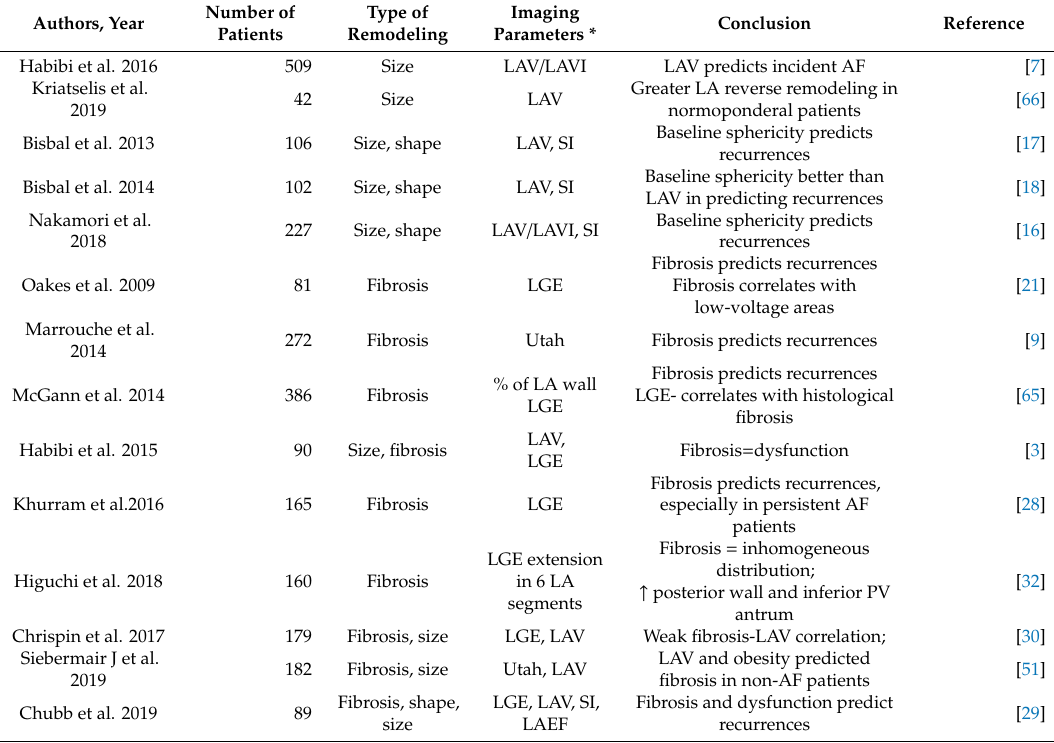
Table 2. Studies focusing on left atrial structural remodelling using cardiac magnetic